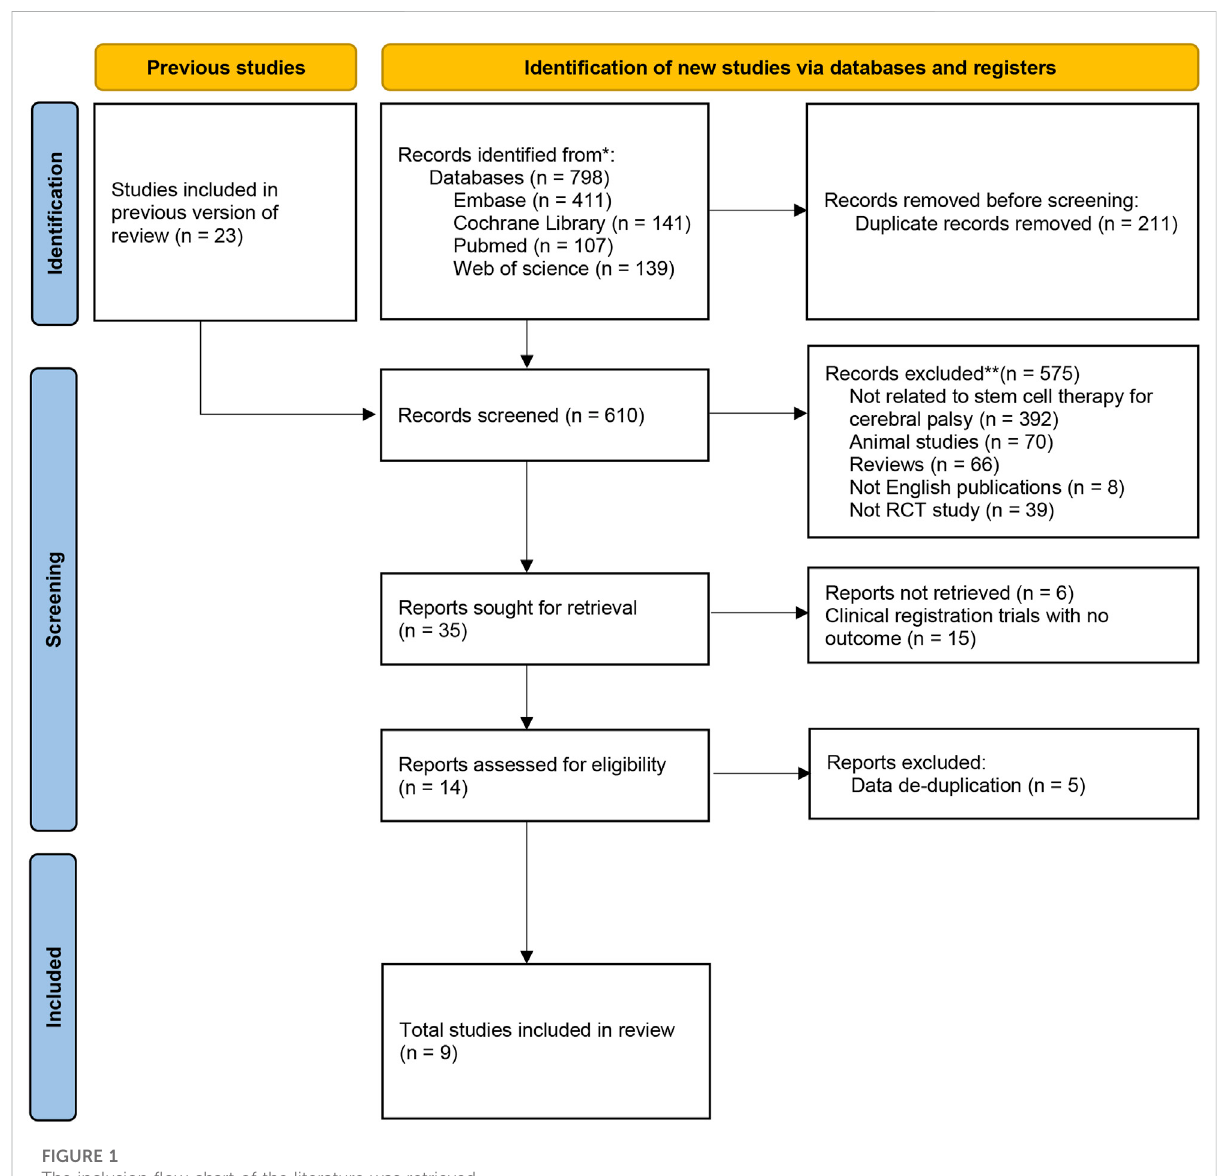
The inclusion fl ow chart of the literature was